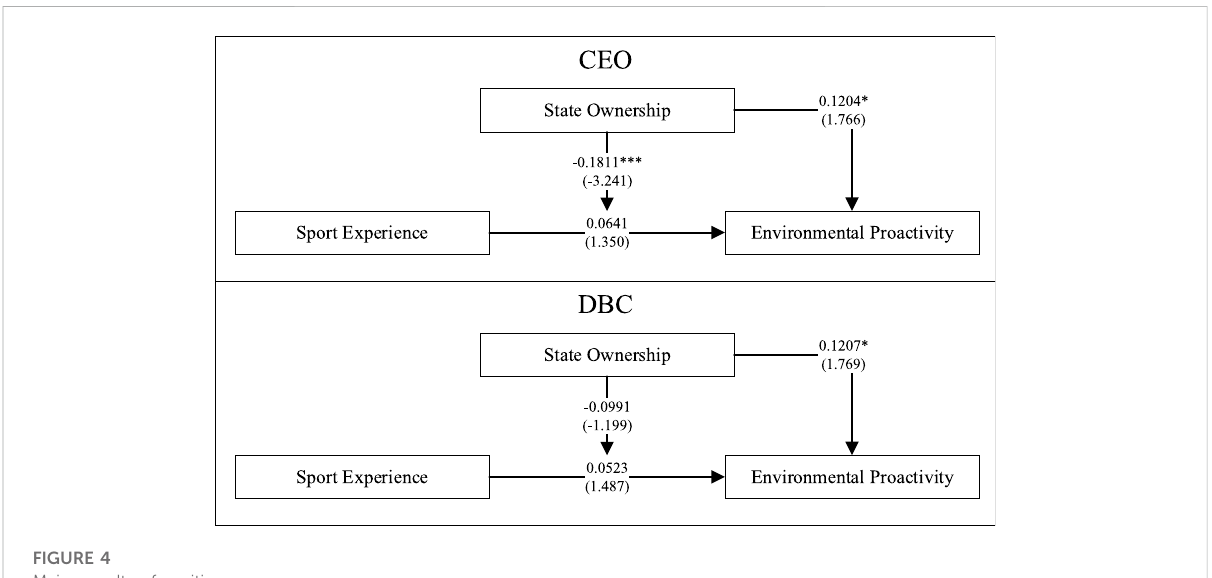
FIGURE 4 Major results of